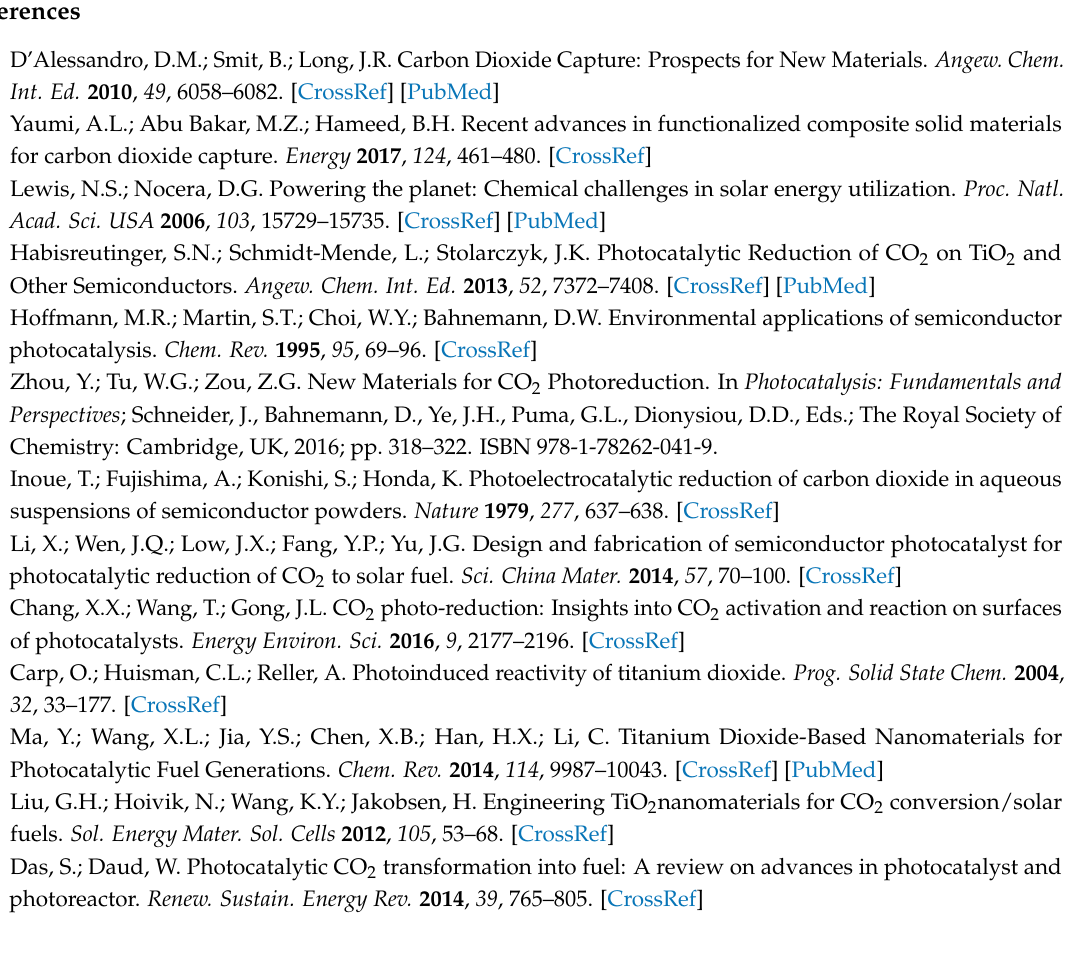
Figure S1: The plot of ( α h ν ) 1/2 versus h ν for the bandgap calculation of A-Ti, Figure S2: ( a ) Nitrogen adsorption and desorption isotherms; and ( b ) pore size distribution curves of A-Ti and A@PDA-1 nm, Figure S3: CO yield comparison of R-Ti and R@PDA-1 nm under Visible light ( a ) and UV-vis light ( b ) for the photoreduction of CO 2 , Figure S4: CO yield comparison of B-Ti and B@PDA-1 nm under Visible light ( a ) and UV-vis light ( b ) for the photoreduction of CO 2 , Figure S5: TEM images of : ( a ) pristine PDA; and ( b ) PDA after illuminating under UV-vis light in N 2 for 6 h, Figure S6: XPS spectra of PDA and PDA after illuminating under UV-vis light in N 2 for 6 h: ( a ) C1s; ( b ) N1s; and ( c )